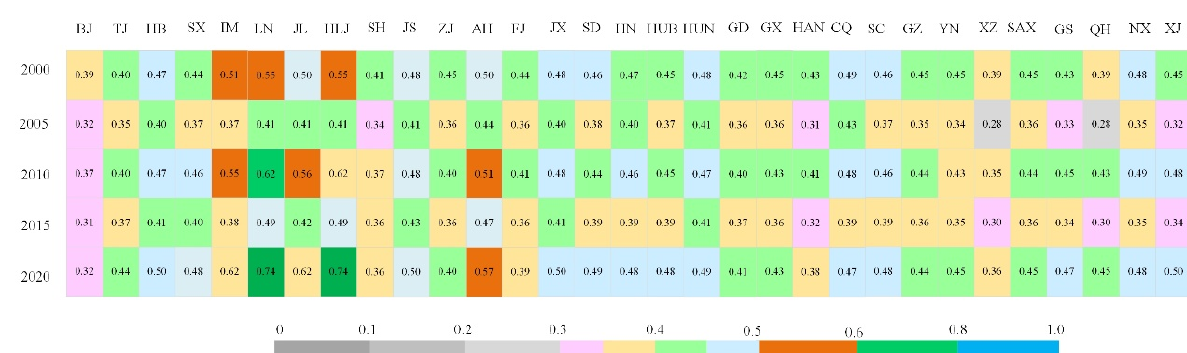
Figure 9. “Water–Land–Food–Carbon” coupling coordination degree. Note: BJ, TJ, HB, SX, IM, LN,